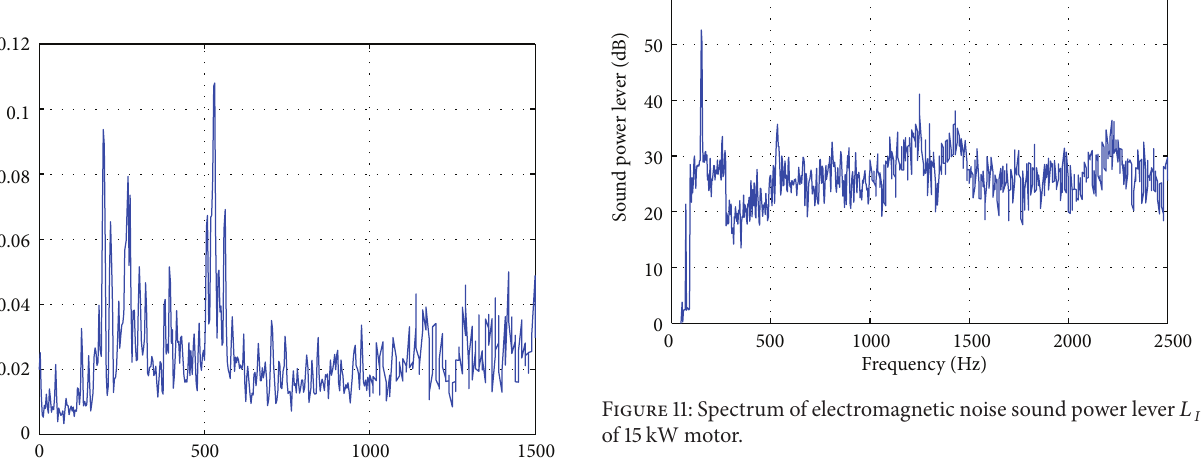
Figure 8: Transfer function by stator system natural frequency experiment.